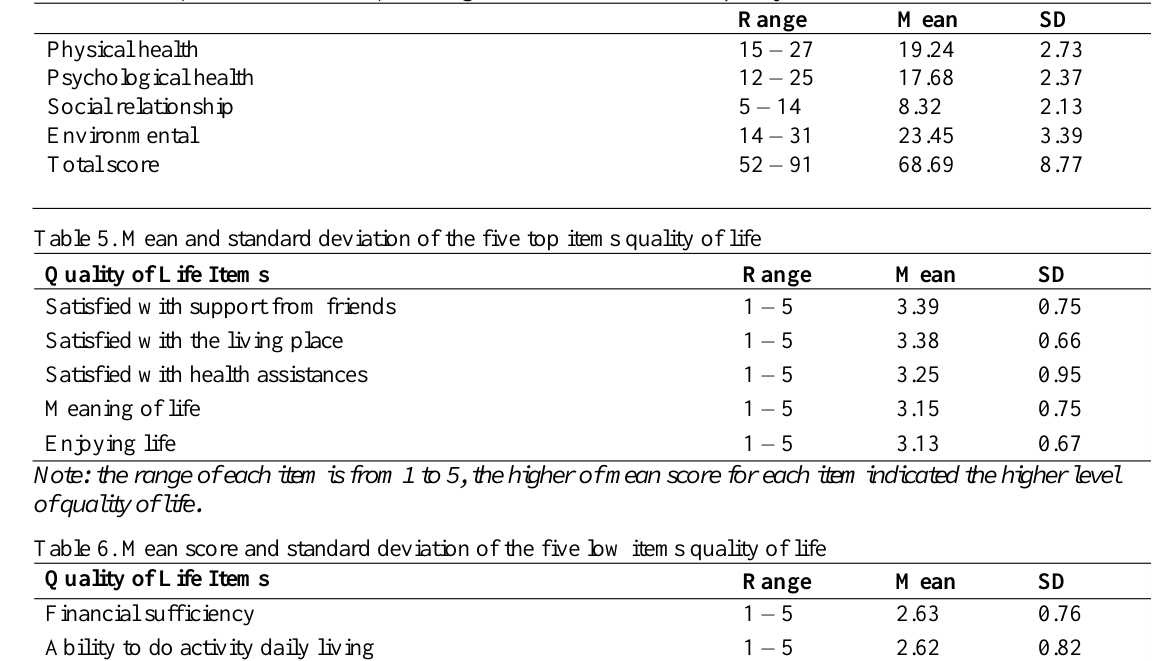
Table 4. Mean, standard deviation, and range for each dimension of quality of life